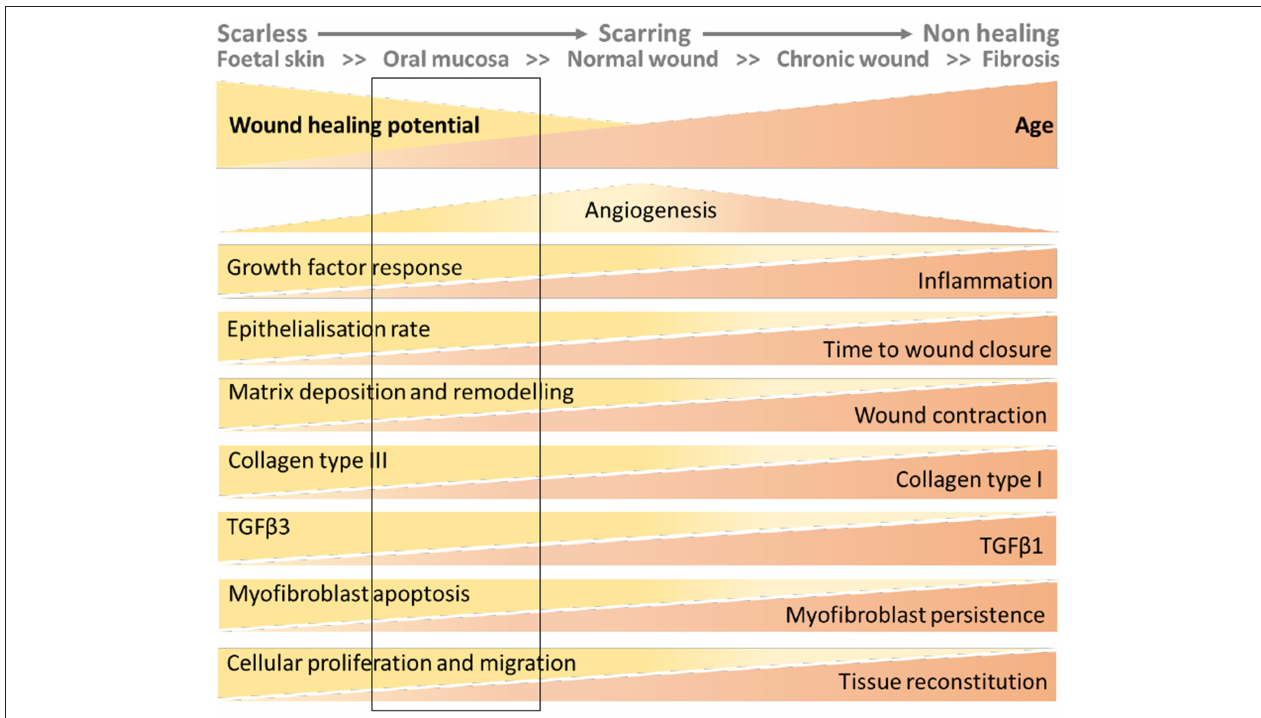
FIGURE 3 | Wound healing continuum with inclusion of putative location of endometrial tissue based on data from the mouse models. The figure has been adapted from that published in (100). The rectangular box added to the figure represents the characteristics of endometrial wound repair based on the interrogation of the mouse models described in this